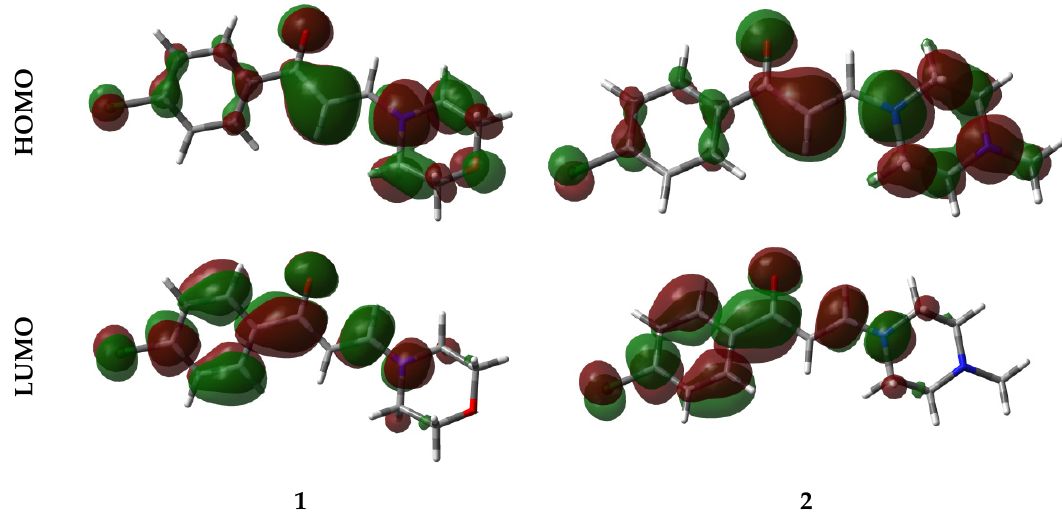
Figure 13. HOMO and LUMO levels of compounds 1 , and 2 .